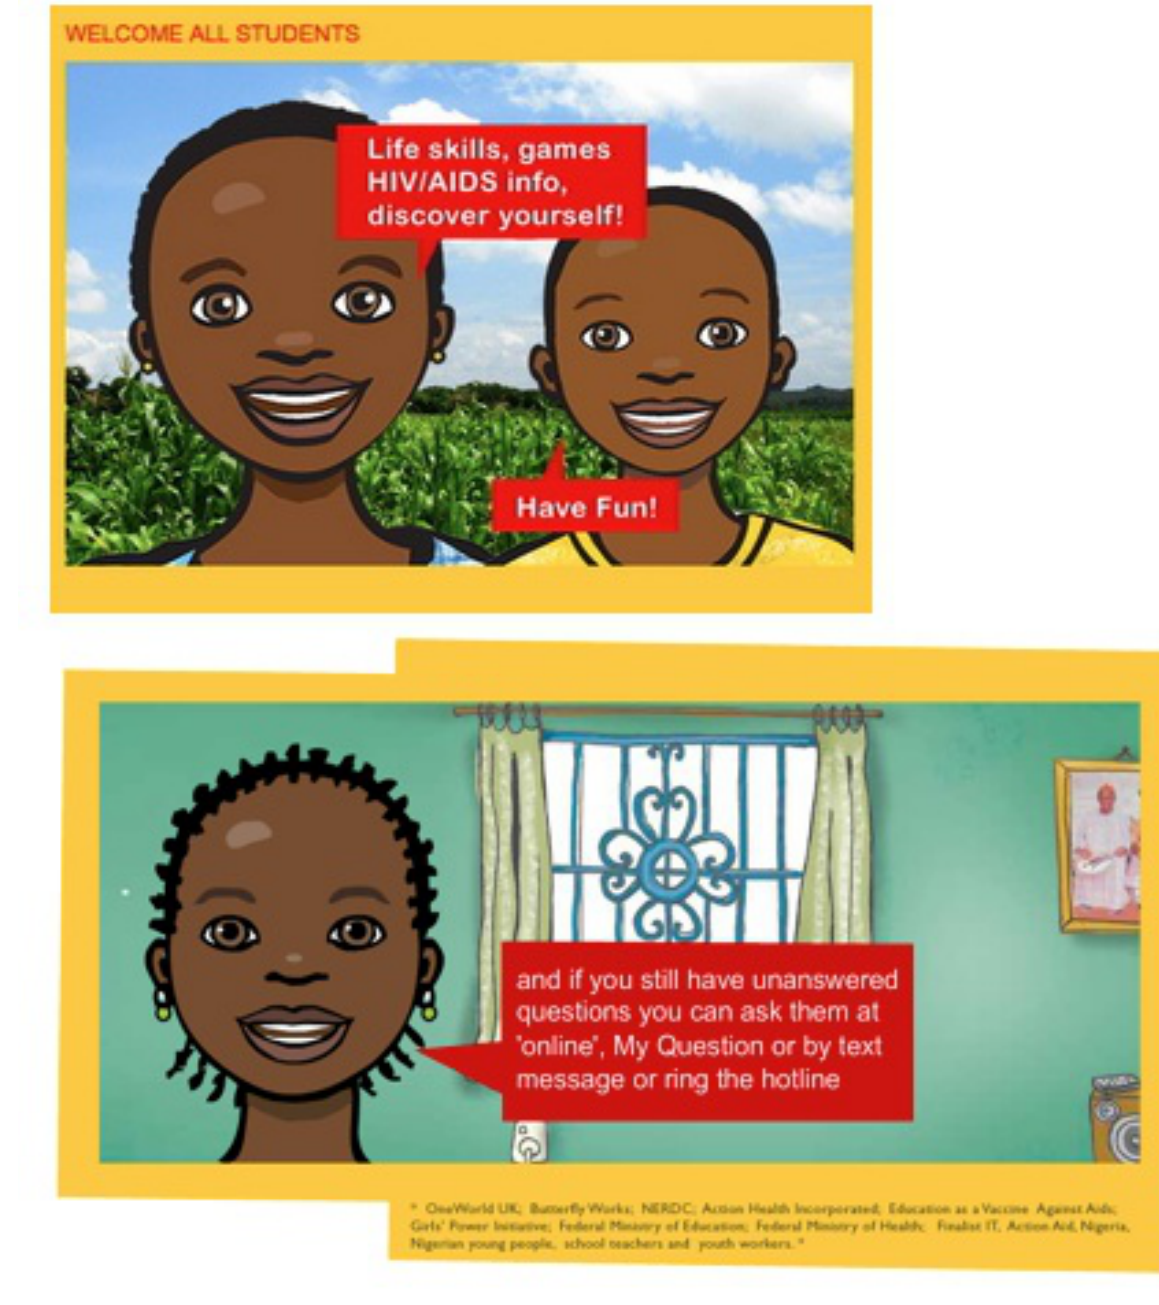
Figure 3. Learning about Living. Reproduced with permission